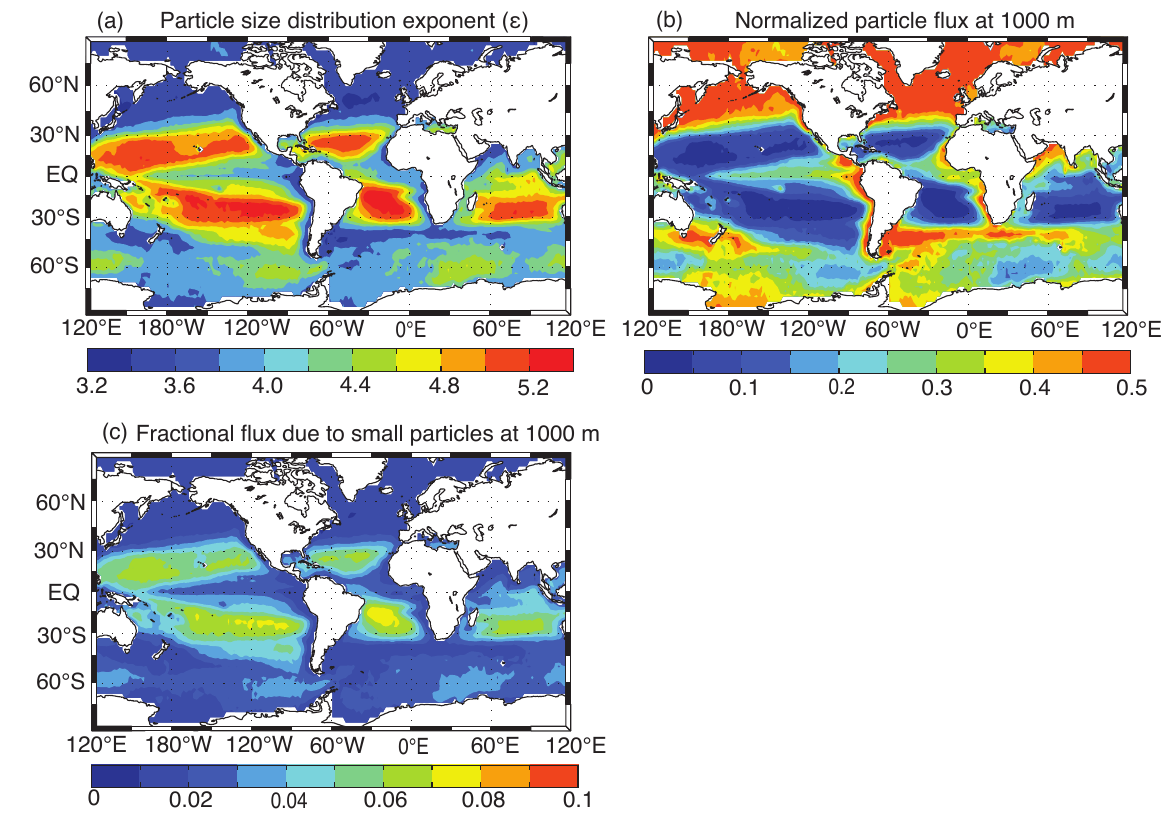
Figure 4. (a) Spatial variability in the exponent for the surface particle size distribution used in PRiSM. Lower values of (cid:15) indicate larger particles, and higher values of (cid:15) indicate smaller particles. (b) Spatial variability in the particle flux at 1000m depth resulting from variability in the surface particle size distribution. (c) The fraction of the flux at 1000m due to small particles (less than 200µm in diameter). For (b) and (c) we used the same parameters of PRiSM as in Fig.